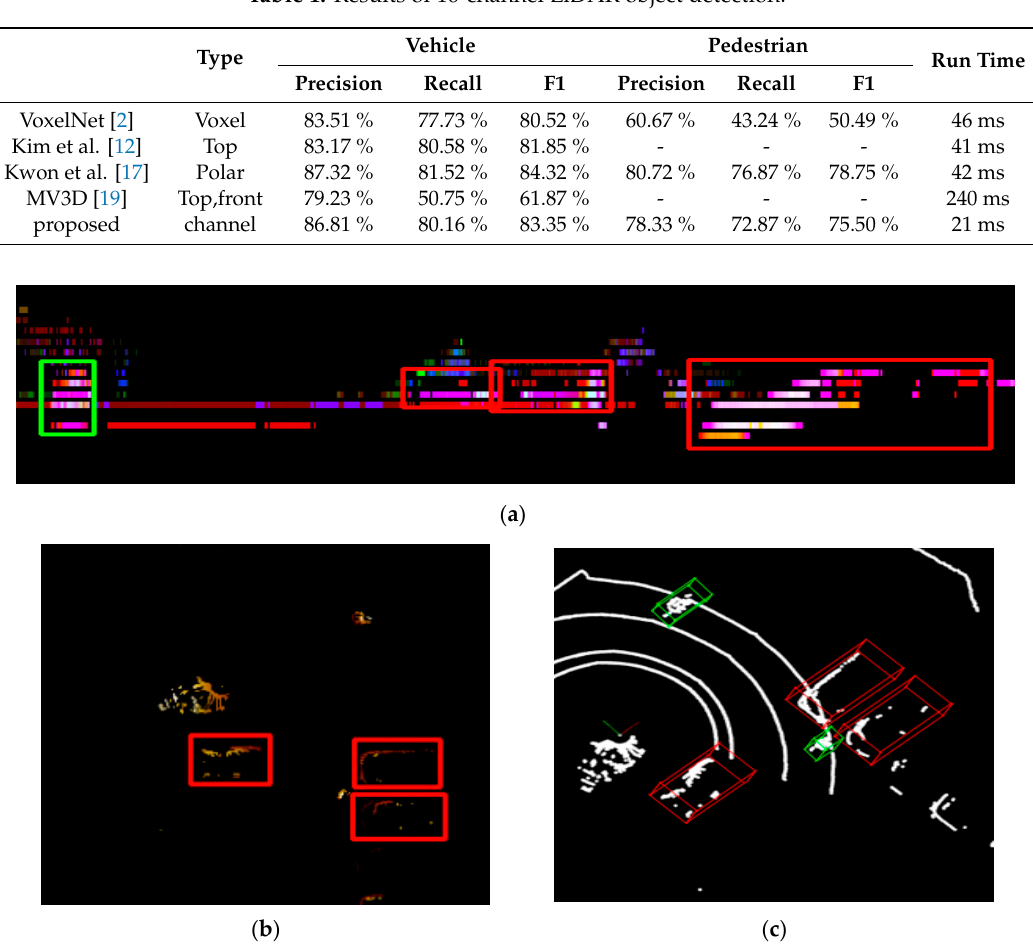
Figure 9. Results of the 16-channel lidar object detection: ( a ) polar-view, ( b ) top-view, ( c ) proposed methods; Vehicle is red, pedestrian is green.